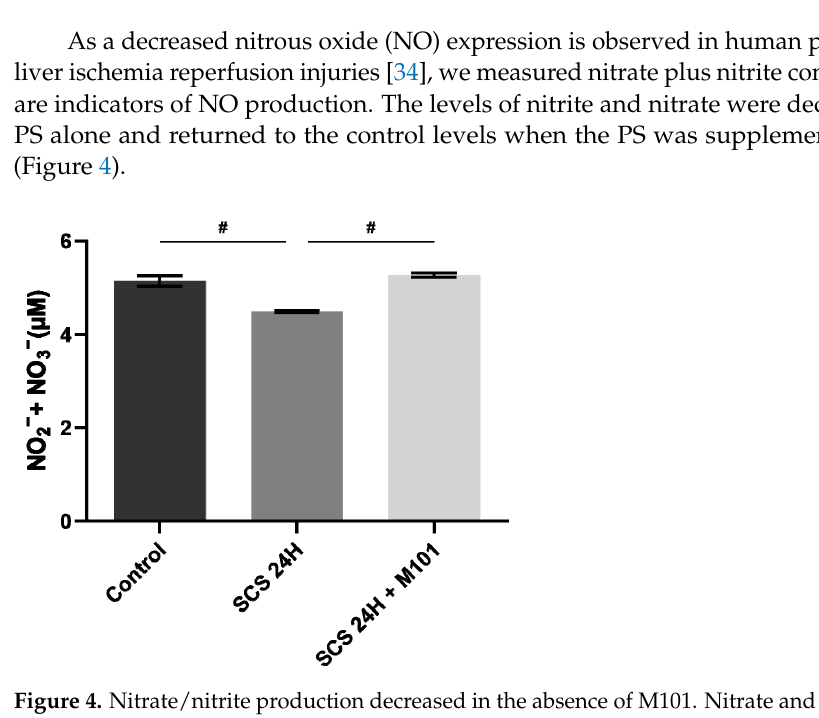
Figure 3. Nuclear injury and oxidative stress. ( A ) HMGB1 expression. ( B ) Malondialdehyde (MDA) levels were both significantly higher in livers preserved 24 h in SCS without the addition of M101, than without SCS (control) or with supplementation of M101. Data are represented as mean (SEM). n = 12/group, * = p < 0.05 vs. control and # = p < 0.05 vs. SCS-24H (one-way ANOVA).